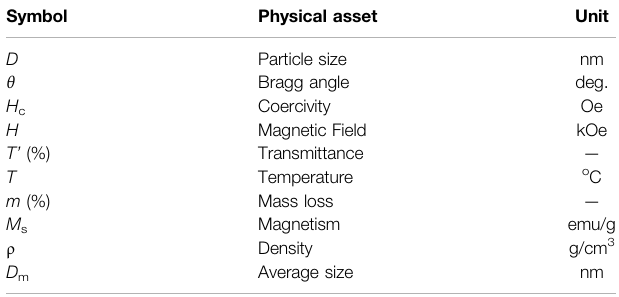
TABLE 2 | All the nomenclatures used in the paper.